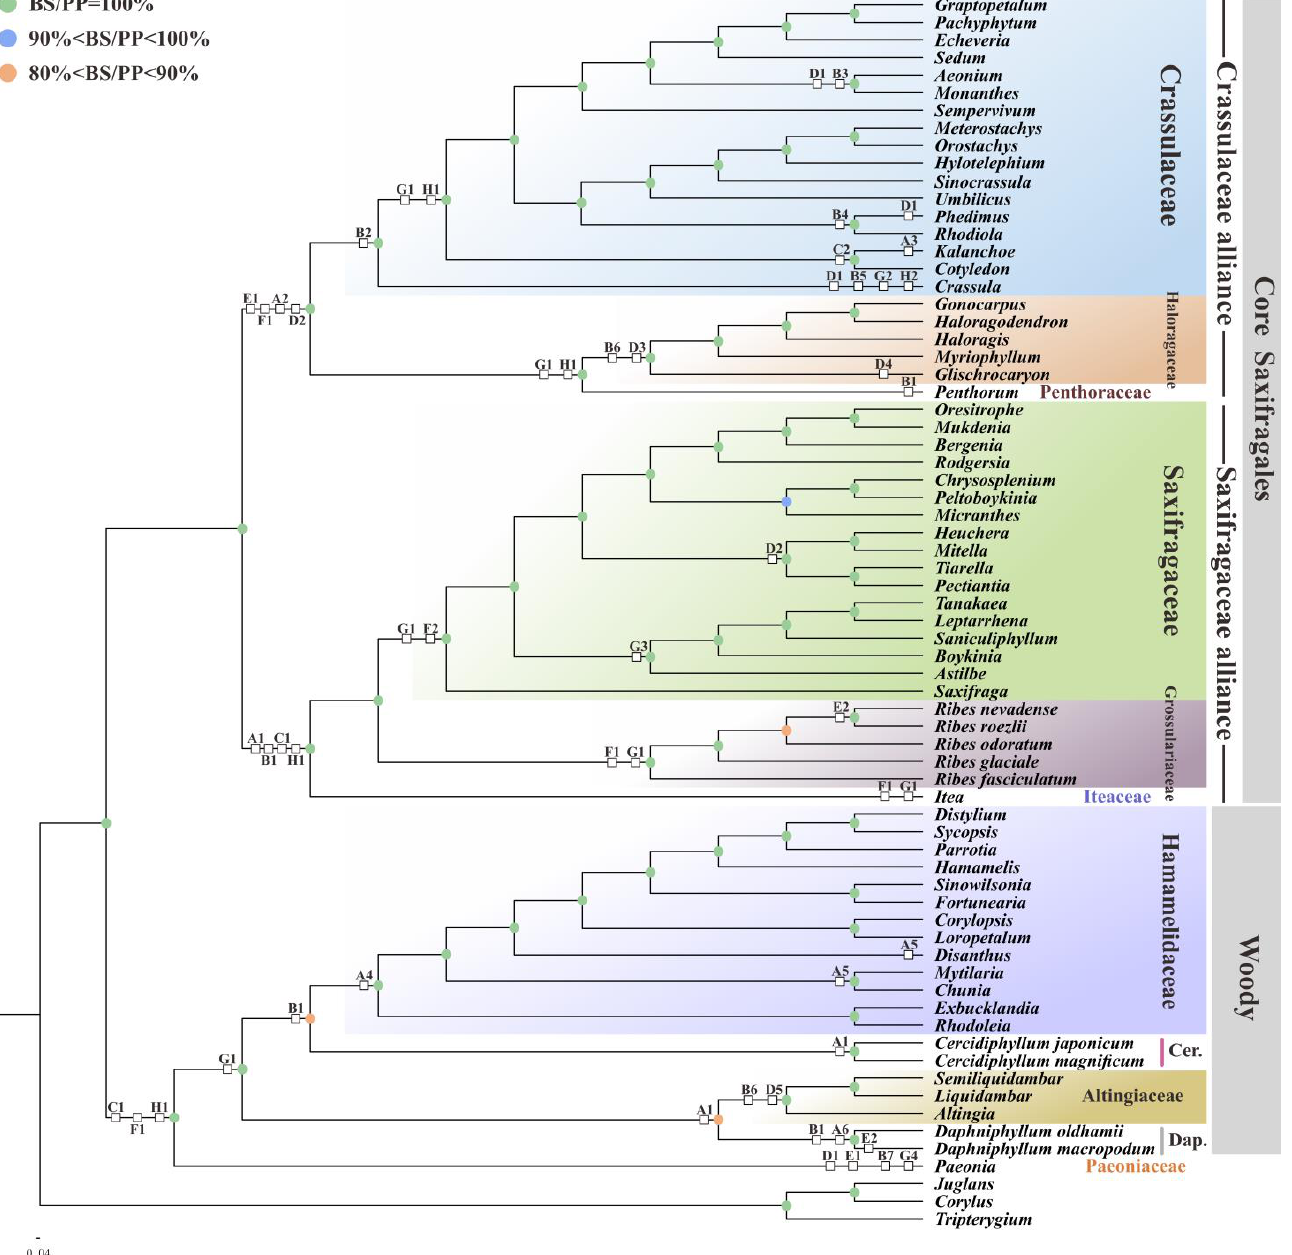
Figure 4. The simplified PCG tree combined with pttRNA structural characteristics. White boxes indicate the specific structures, which are detailed in Table 3. Note that the families Cercidiphyllaceae and Daphniphyllaceae are abbreviated as Cer. and Dap., respectively. Table 3. The evolutionary signals identified from the structures of pttRNAs among Saxifragales. Types of pttRNAs